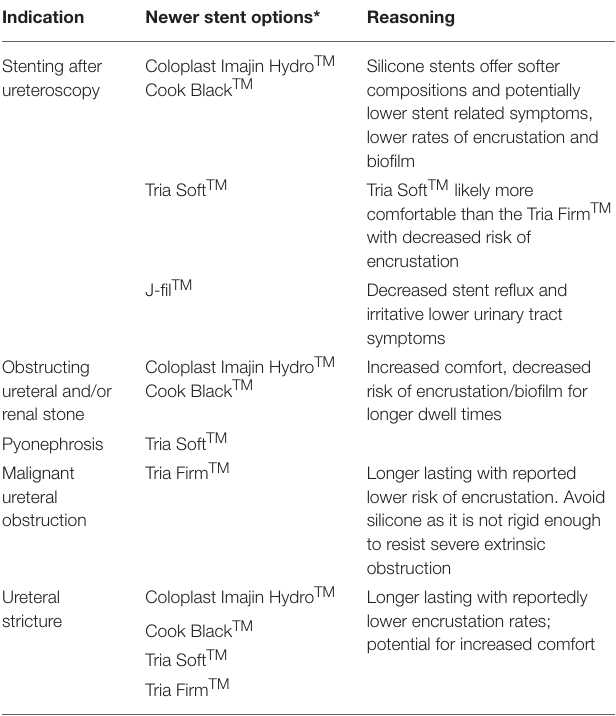
TABLE 3 | Recommendations for different novel ureteral stent options based on various indications.